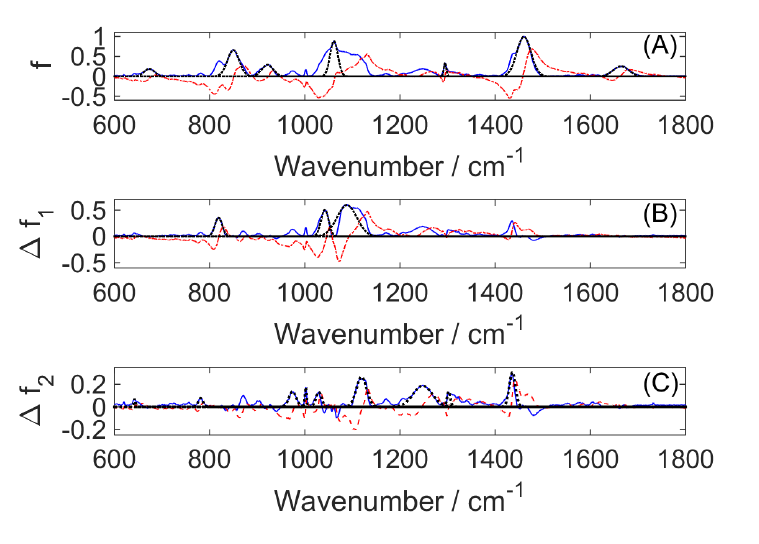
Figure 7. Three iterations of the cascade Hilbert-Zero decomposition applied to the Raman spectra shown in Figure 6. Blue solid curves show the initial signal processed during the first iteration ( A ) and two sequential residuals ( B , C ), and the red dash-dotted curves are the respecting Hilbert transform curves. Black dotted bell-shaped curves are the Gaussian components for each